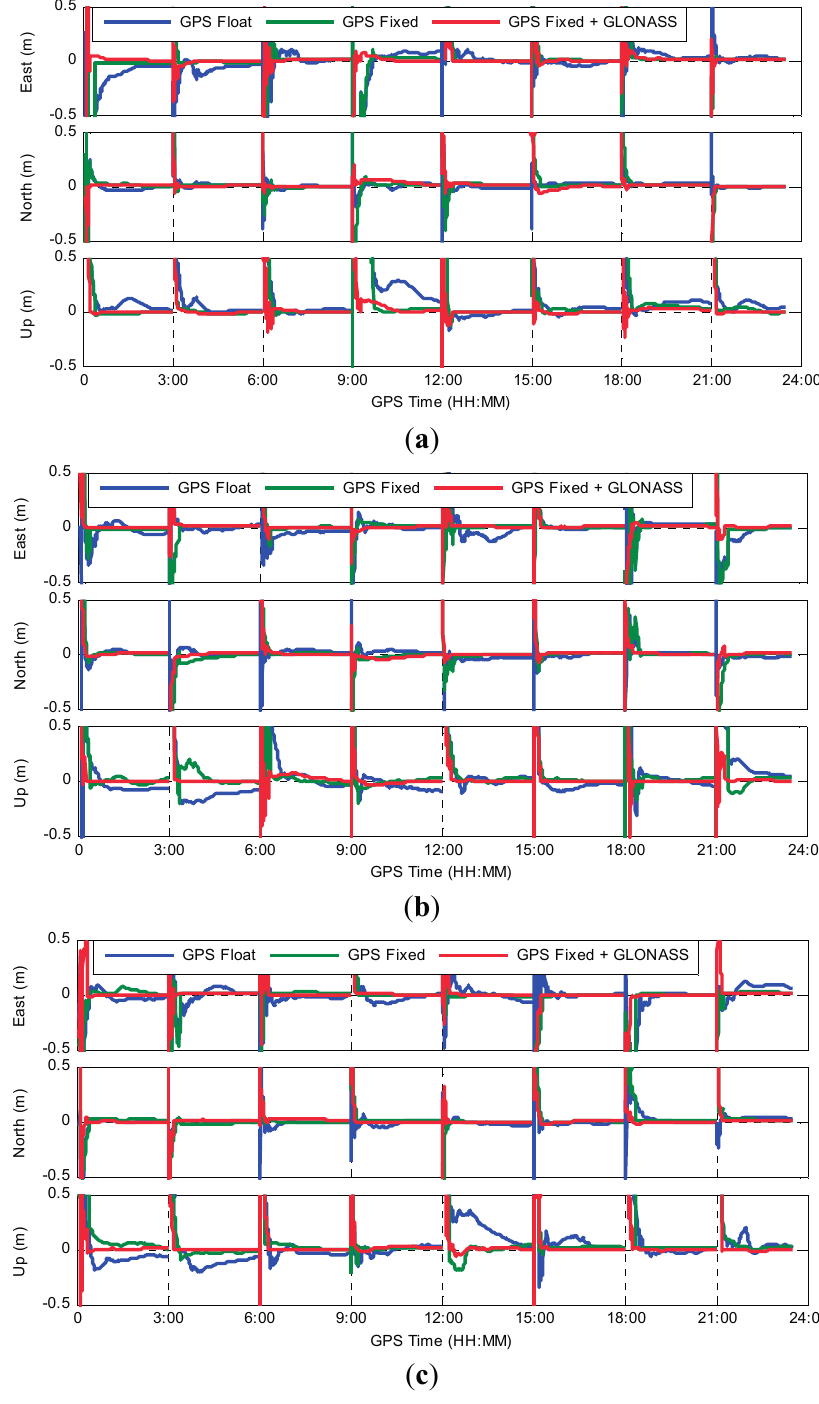
Figure 7. Positioning errors for GPS ambiguity-float PPP, GPS ambiguity-fixed PPP and GGPPP-FGA using observations on 1 February 2014. The IGS datasets are collected from ( a ) a high latitude station KIR0, ( b ) a mid-latitude station BJFS, and ( c ) a low latitude station